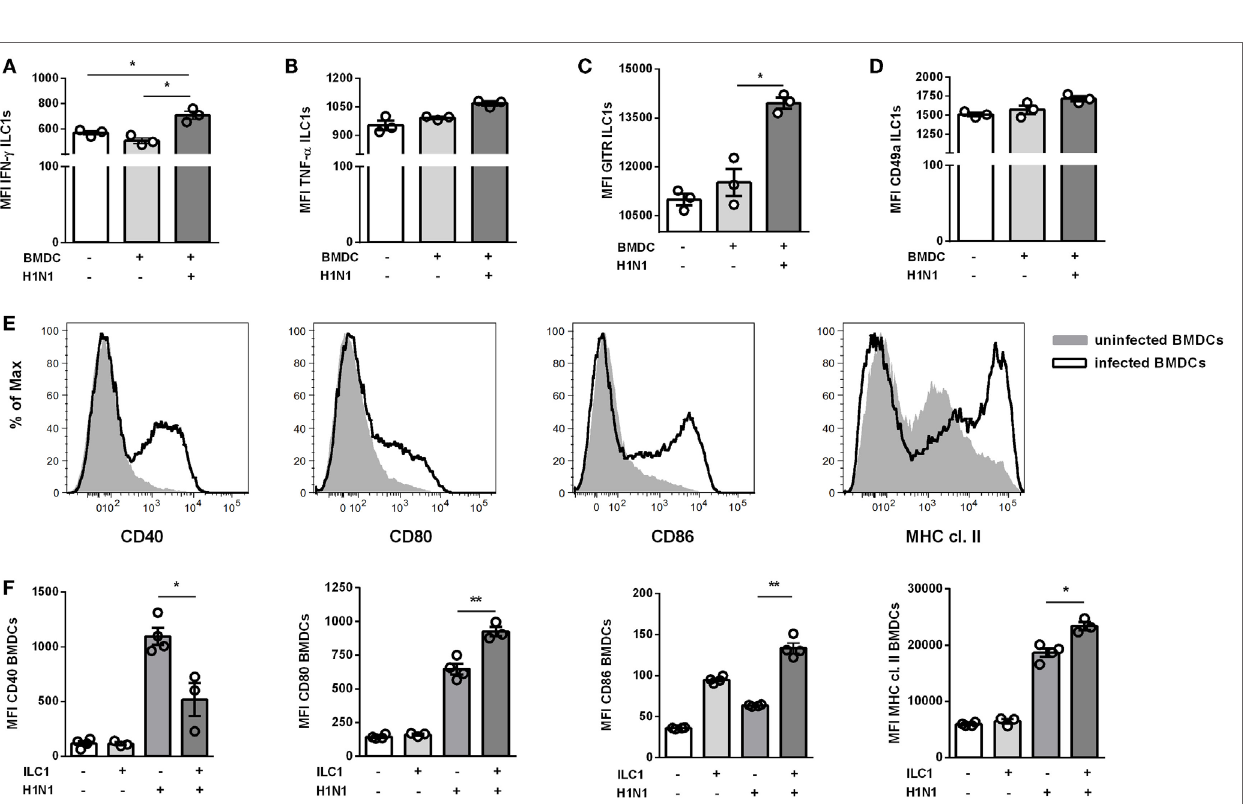
FigUre 3 | GITR expression level defines responsiveness of IL-12- and IL-18-induced ILC1 activation. In vitro -generated ILC1s were stimulated with 100 ng/ml of IL-12 ± IL-18 for 48 h and incubated at 37°C in medium containing brefeldin and monensin for 3 h prior to the flow cytometry of markers related to ILC1 activation and functionality. The bars with scatter plots represent the MFI values ( n = 3–4). (a) Representative histogram depicts GITR expression on ILC1s at steady state (gray filled line = fmo control, black line = ILC1s) and (B) MFI of GITR expression by ILC1s post-IL-12 ± IL-18 treatment. Changes in expression densities and frequencies of GITR lo and GITR hi ILC1s expressing (c) IFN- γ and (D) TNF- α . MFI data are representative from one out of two independent experiments. Asterisks denote significant values as calculated by nonparametric Kruskal–Wallis test (Dunn’s posttest) as compared to untreated samples; **** p ≤ 0.0001; *** p ≤ 0.001; ** p ≤ 0.01; * p ≤ 0.05.